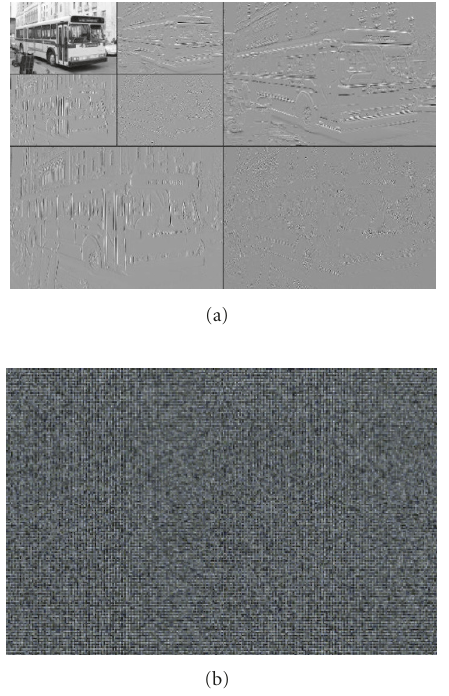
Figure 9: (a) 2-level Haar wavelet decomposition; (b) a share cre- ated from the Haar wavelet